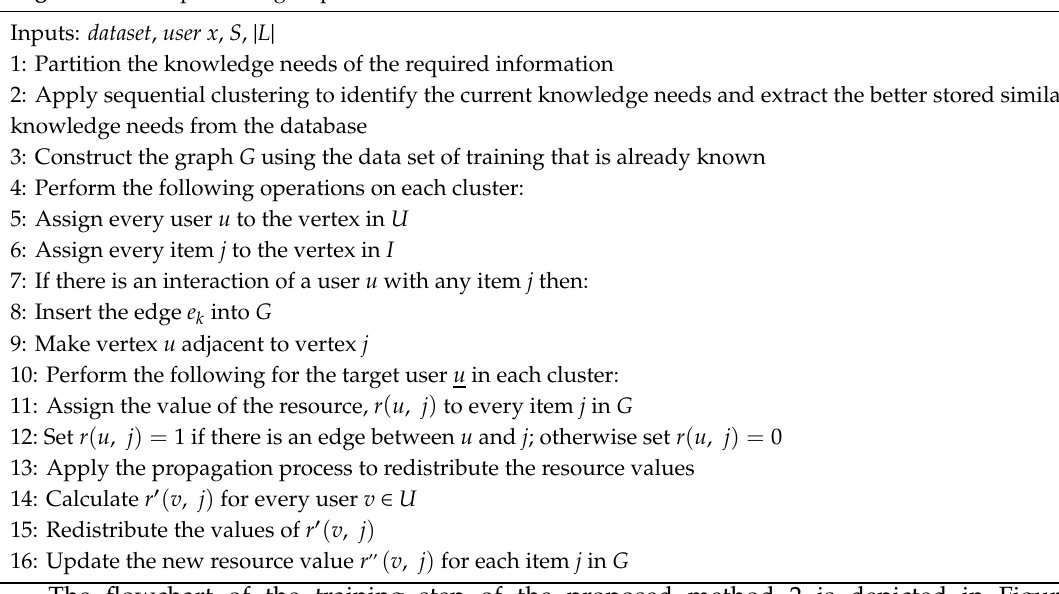
Algorithm 2: Preprocessing—Specific Features based Personalized